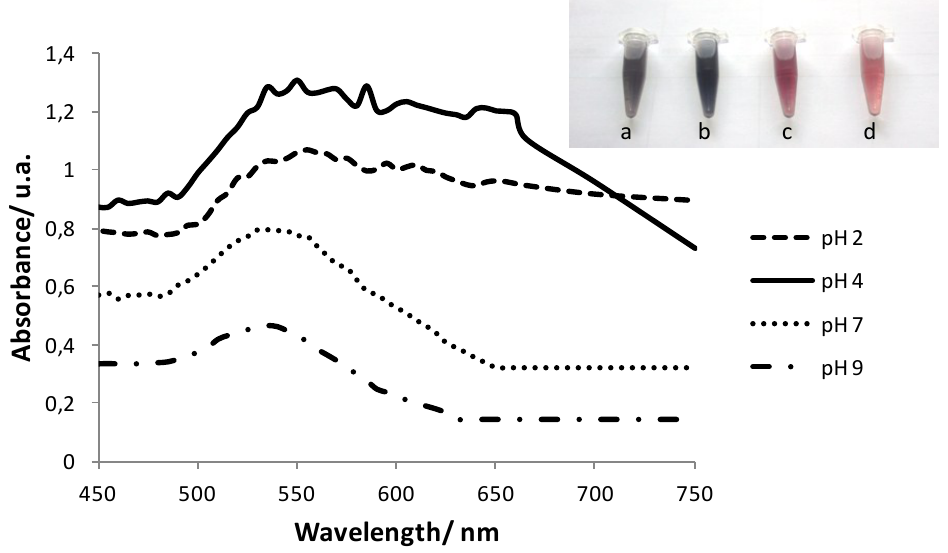
Figure 1. UV-VIS spectra of gold nanoparticles using 100 mg/L HAuCl 4 prepared at different initial pH values: pH 2, 4, 7, and 9. The inset shows the solutions corresponding to these spectra: ( a ) pH 2; ( b ) pH 4; ( c ) pH 7; and ( d ) pH